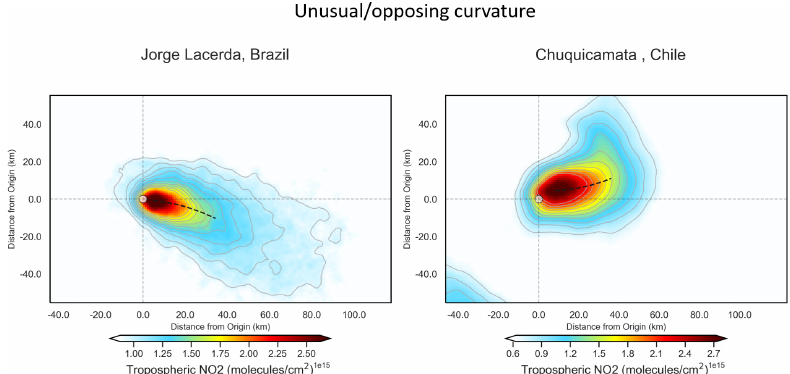
Figure A3. Wind-rotated aggregates of the non-conforming sites, with the plume spine signified by the dashed black line.